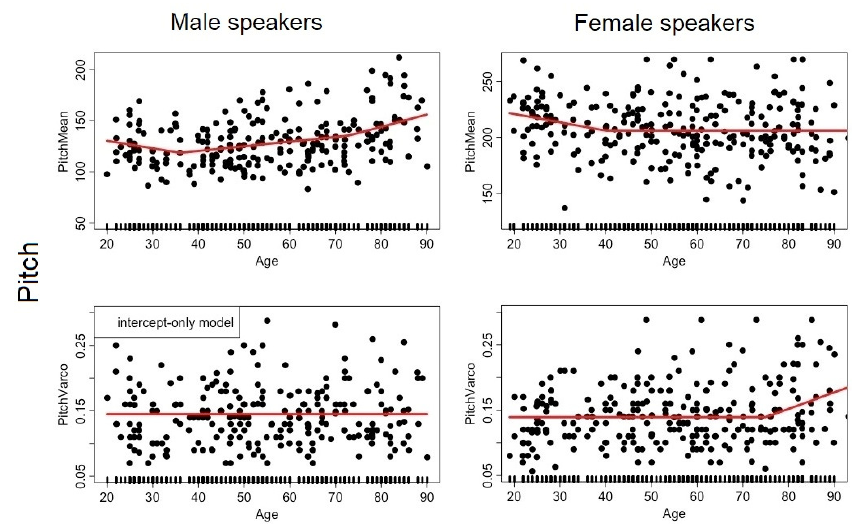
Figure A2. Dot plot of each descriptor ( y -axis) capturing aspects of the PITCH dimension as a function of age ( x -axis) for the male ( left ) and female ( right ) speakers. The hinge function of the MARS model is represented by the red curve. Each dot corresponds to a speaker.